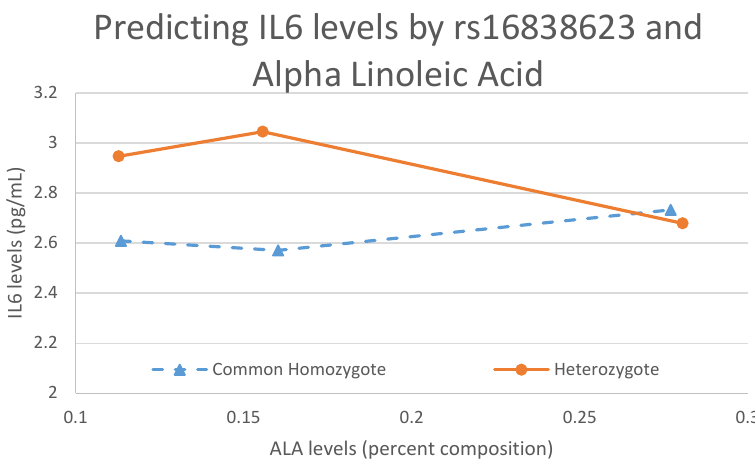
Figure 2. An interaction plot between ALA and rs16838623 predicting IL6 levels. This figure shows the modulating effects the genotype has on FAs and the effect that interaction has on biomarker levels. The rare homozygote is not included in this plot because, in our sample, there is only one individual with that genotype.